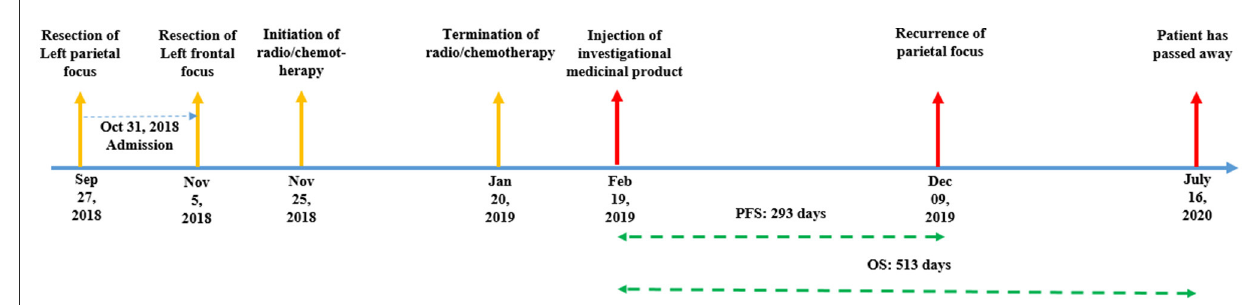
FIGURE1 Timeline of the case presentation.